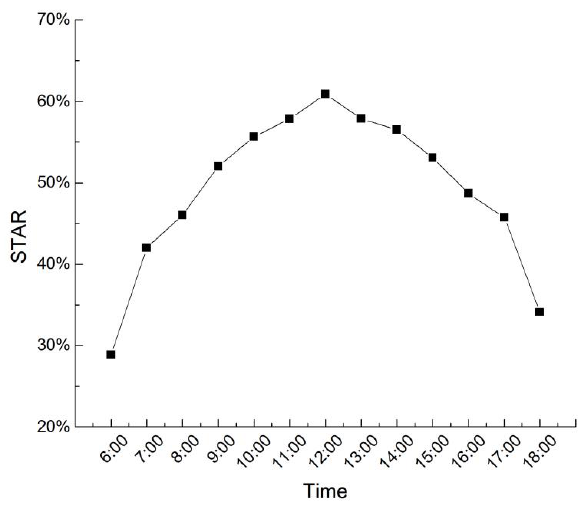
Figure 11. Daily variation in STAR for the loquat model at the whole canopy level.